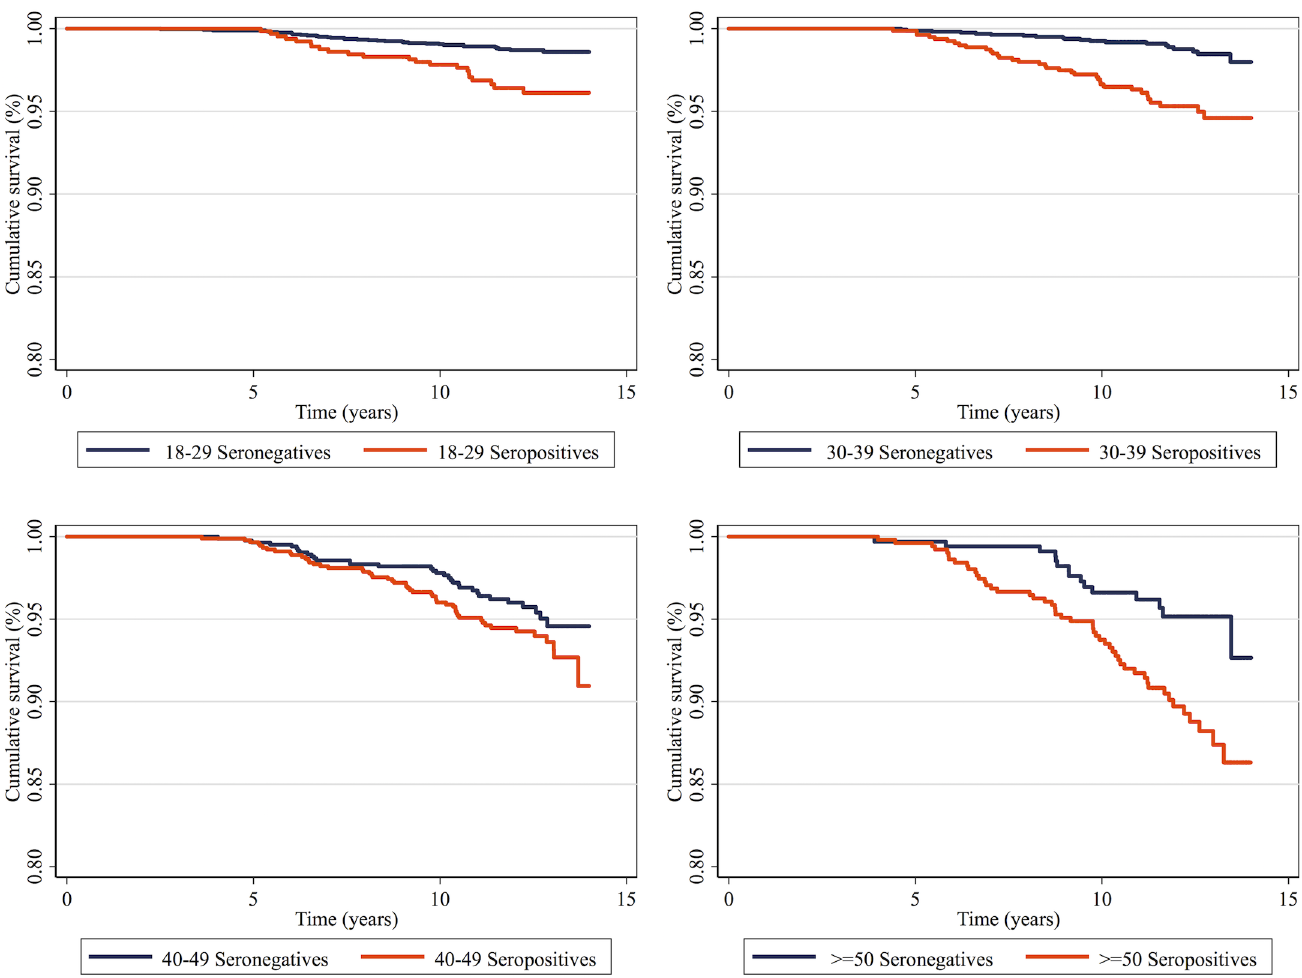
Fig 2. Cumulative survival of blood donors at FPS, S ã o Paulo, Brazil, from 1996–2000, by T . cruzi serology status and age